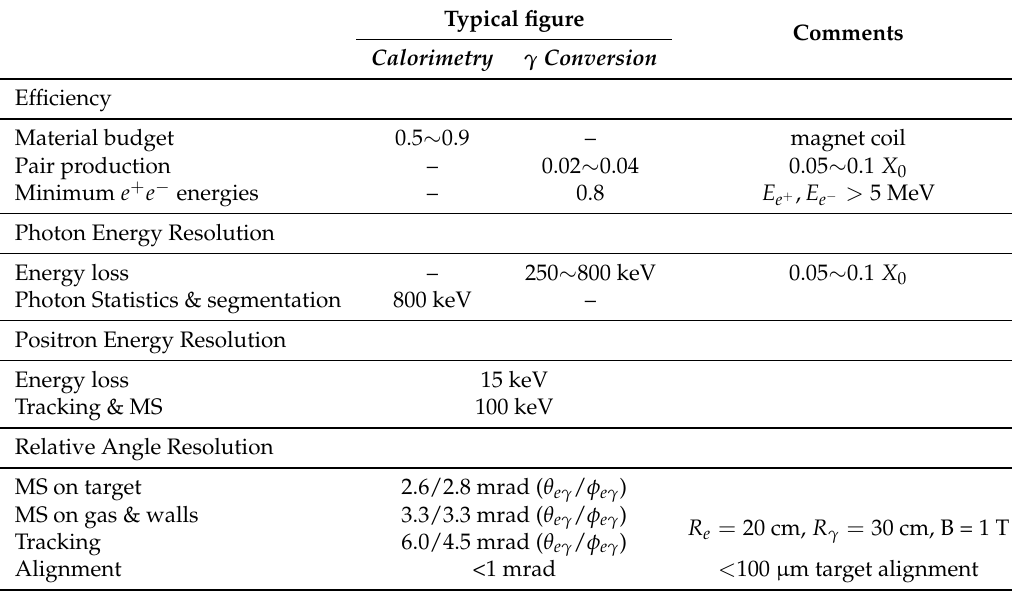
Table 2. Limiting factors for the efficiency and resolutions of future µ + → e + γ searches. Typical